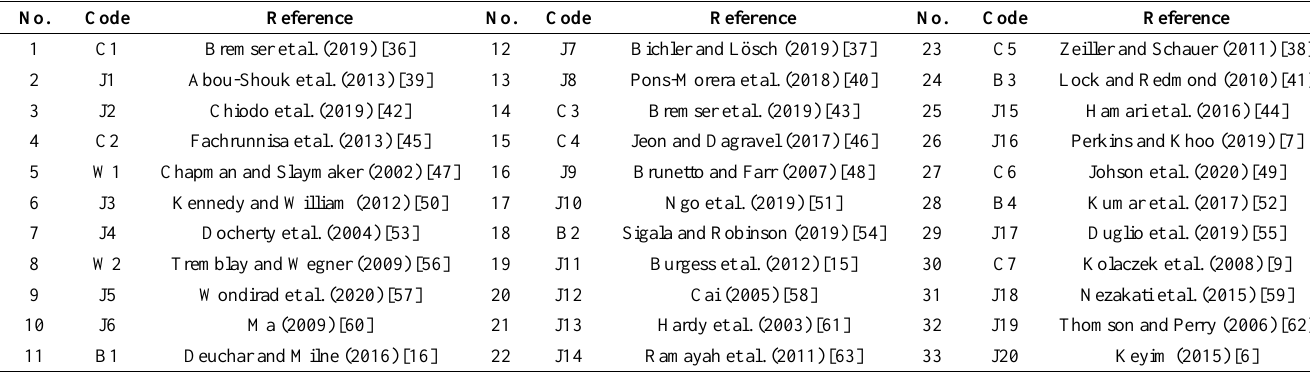
Table 3. Final Results of Paper Selection for Meta-Analyses Process.